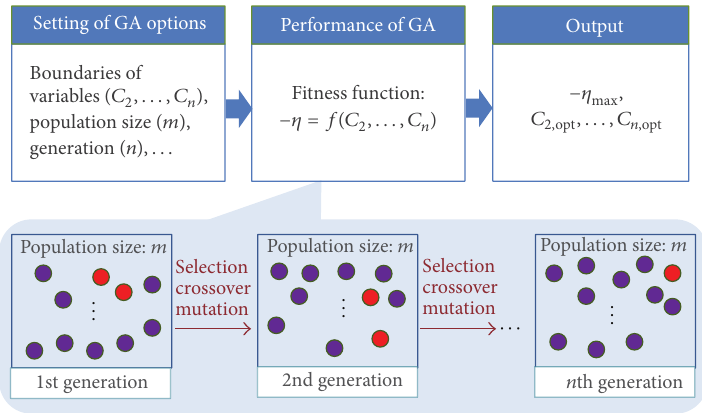
Figure 3: Procedure of GA.